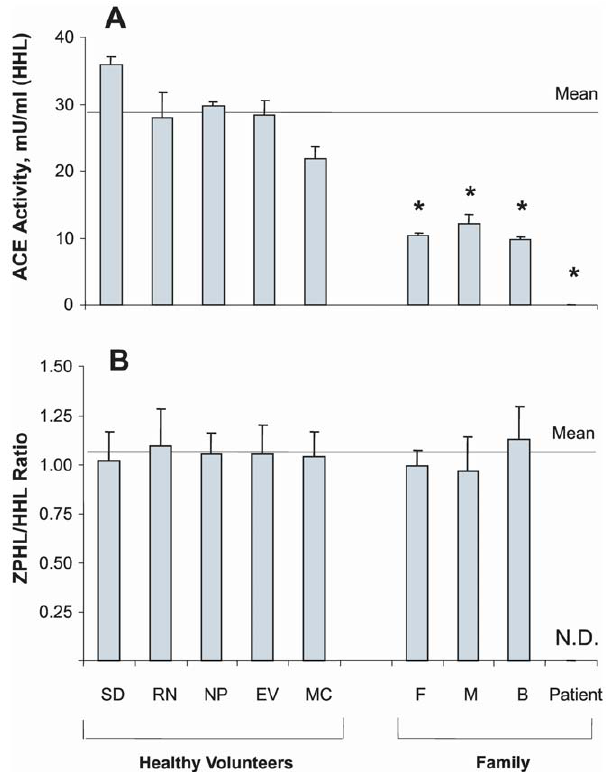
Figure 1. Plasma ACE activity of the members of the affected family. ACE activity in heparinized plasma (1/5 dilution in PBS) of members of the affected family, the father (F), mother (M), and brother (B) as well as in 5 healthy individuals (marked by initials) that served as controls was determined by fluorimetric assay of 40 m l diluted plasma with 200 m l each of substrates Hip-His-Leu (HHL) and Z-Phe-His- Leu(ZPHL) during 1 hour of incubation. A. ACE activity with HHL: mean ( 6 SD) of three independent determinations. B. Ratio of hydrolysis of the two substrates ( ZPHL/HHL ratio ) in the tested samples, which is used to characterize for each catalytic domain of ACE in somatic two-domain ACE [28]. ND-not determined. * p , 0.05 vs. control